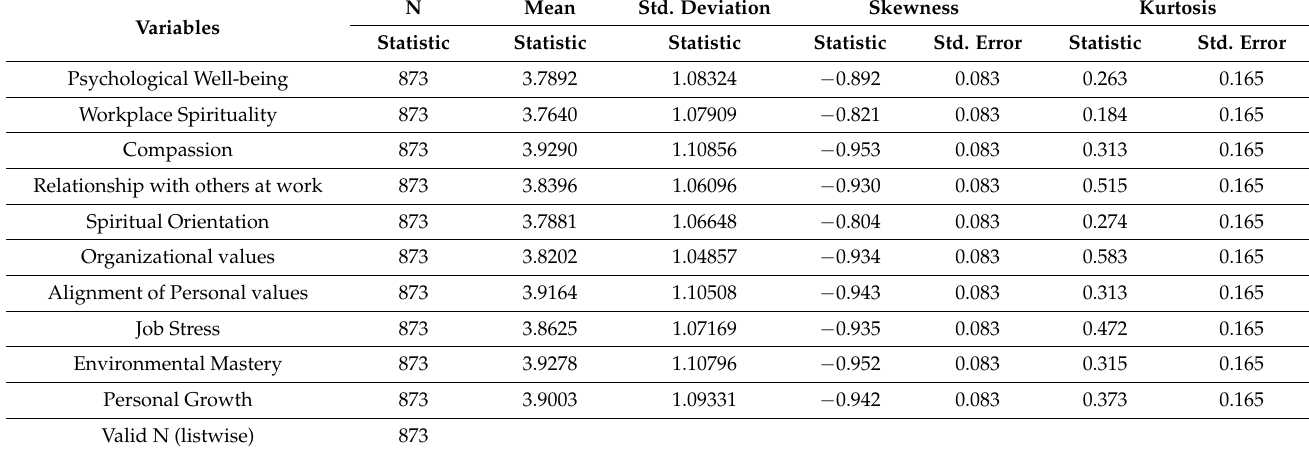
Table 2. Descriptive